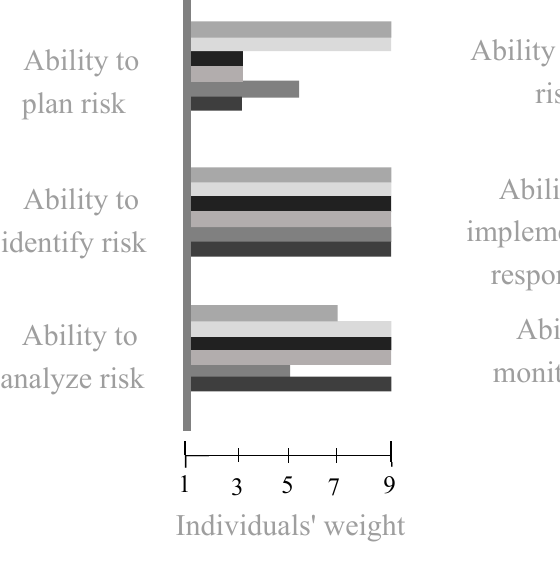
Figure 5. The individuals' response weights per each attribute.